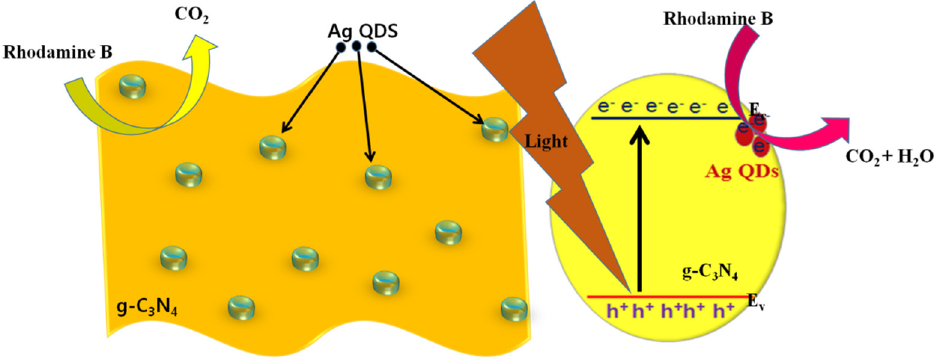
Figure 12. Schematic representation of the dye degradation mechanism under light irradiation.